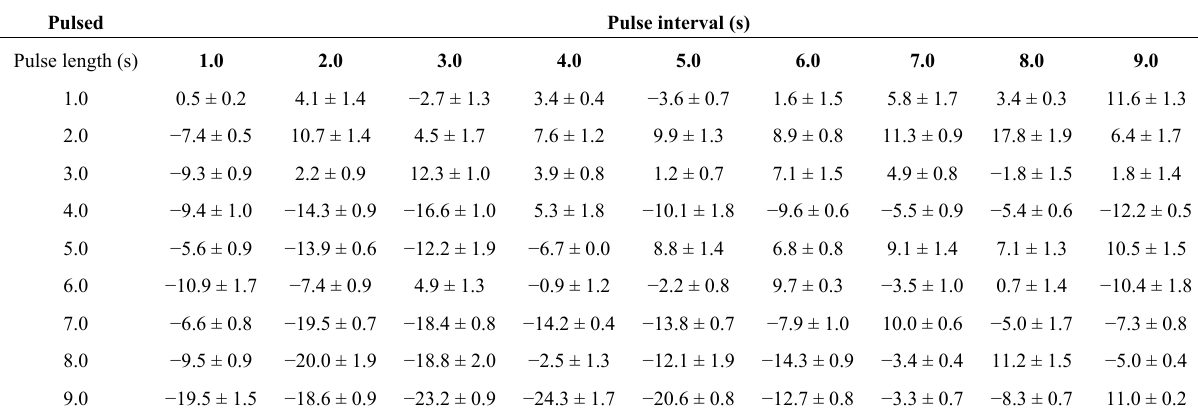
Table 2. PE values at each pulsed setting: pulse length (1–9 s), pulse interval (1–9